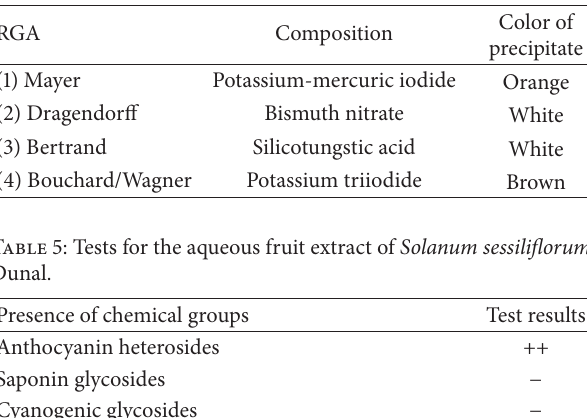
Table 4: Reagent composition and color of precipitate for the